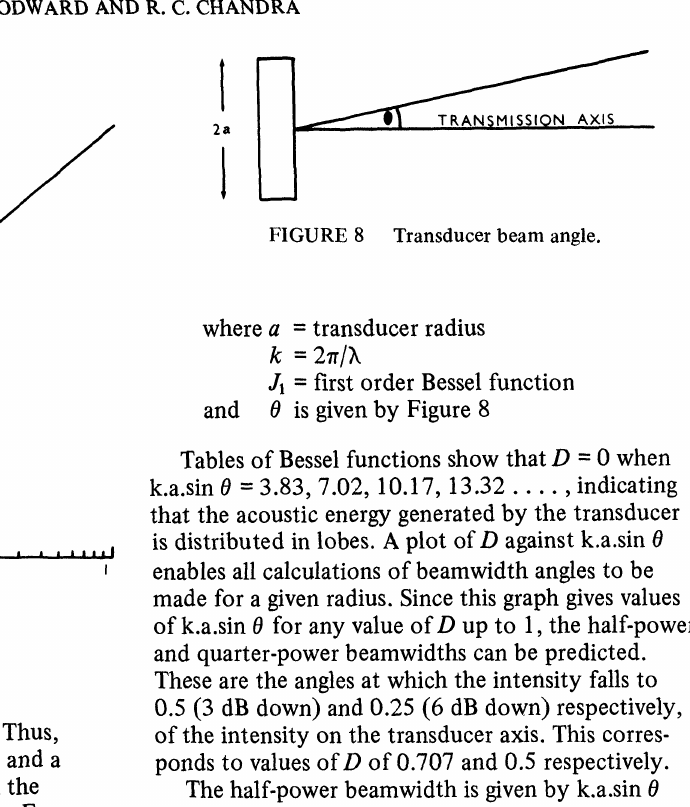
FIGURE 8 Transducer beam